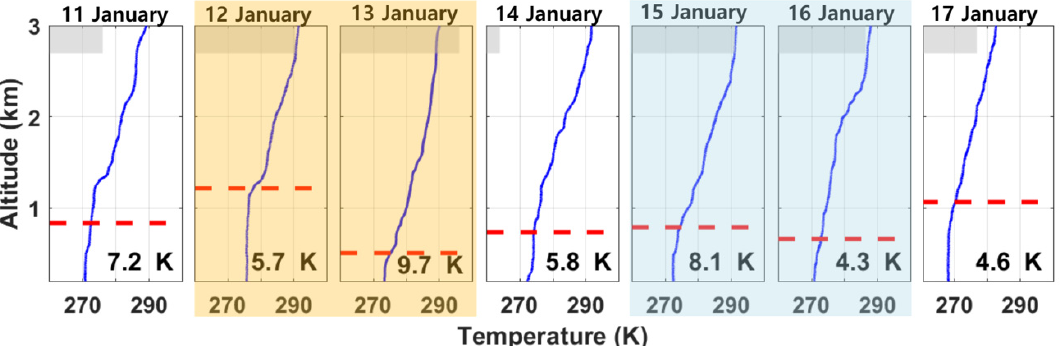
Figure 5. Vertical profiles of potential temperature (unit: K) from rawinsonde at 0600 UTC during 11 to 17 January at Osan, with the corresponding BLH (red dashed line) as computed using the Heffter’s method. The numbers in the lower part and gray shading in the upper part indicate LTS from rawinsonde and total cloud fraction based on LDAPS at 0600 UTC, respectively. Orange and blue shadings indicate the first and second periods, respectively.